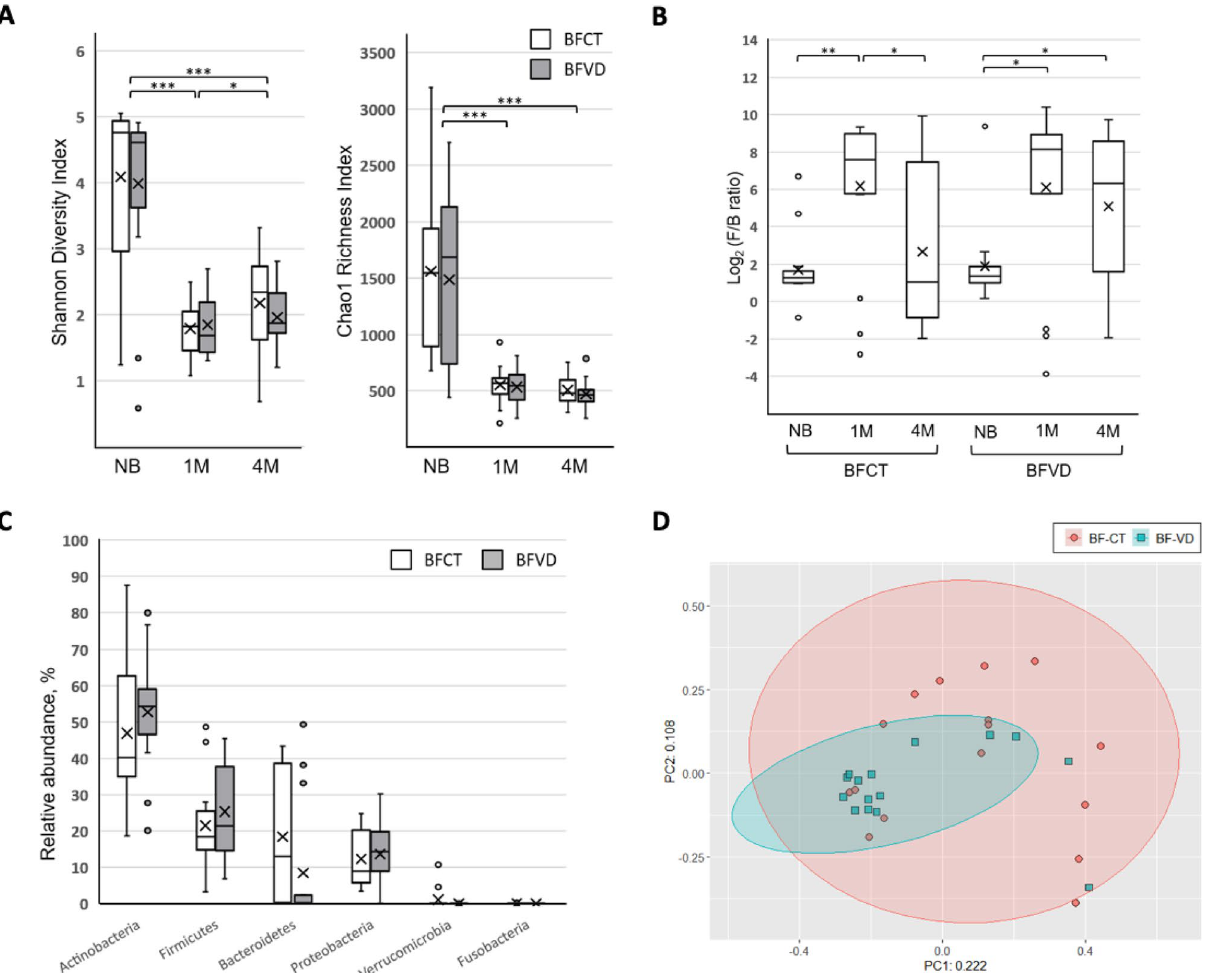
Figure 4. Comparison of relative abundances of microbial taxa between breastfed infants with and without vitamin D supplementation. ( A ) Diversity and richness of bacterial communities in the BFCT and BFVD groups. ( B ) Box plot of log F/B ratio of the BFCT and BFVD groups. ( C ) Relative abundances of bacterial phyla within fecal microbiota of BFCT and BFVD infants at 4-month-old of age. ( D ) Principal Co-ordinate Analysis based on unweighted UniFrac distance of the OTUs in BFCT and BFVD samples at 4-mont h-old of age. Pairwise comparisons using Mann–Whitney test. *P < 0.05. **P < 0.0005. ***P <